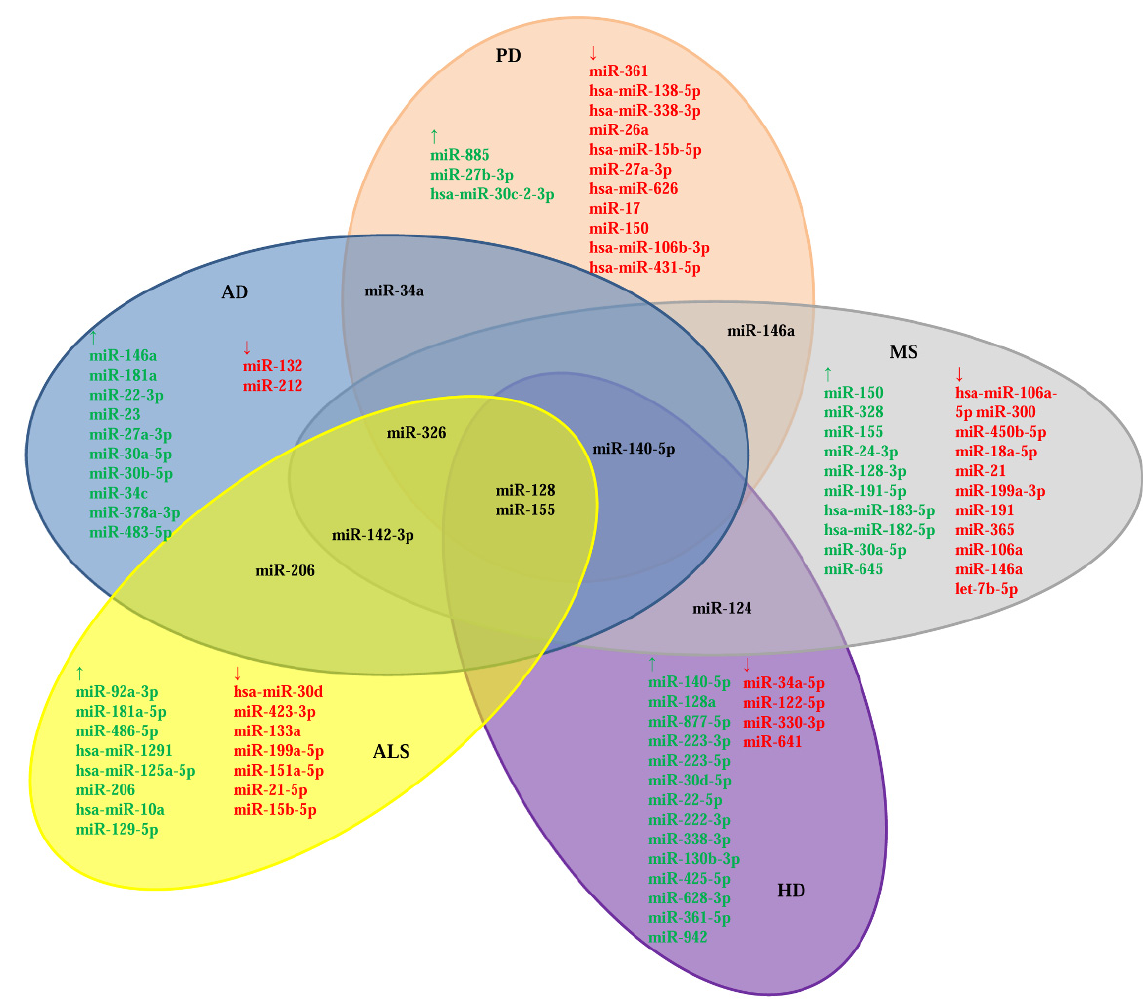
Figure 2. miRNA interconnection among NDs. ↑ : upregulated; ↓ : downregulated. Recently, a PRISMA-based review reported that miR-146a-5p, miR-155-5p, and miR- 223-3p were upregulated in tissues and animal models of 12 NDs including AD, HD, ALS,